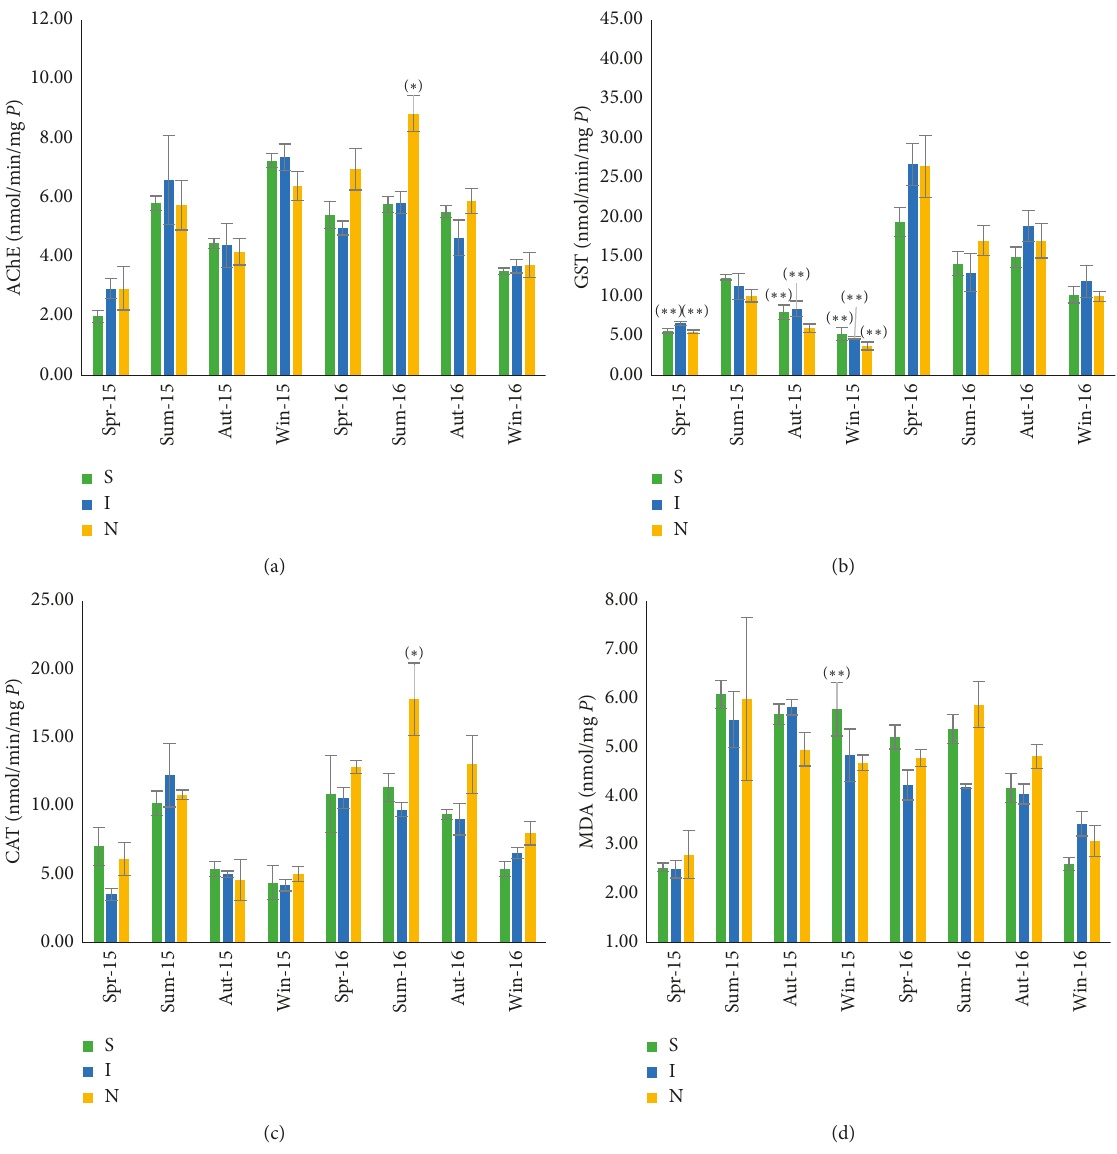
Figure 3: Seasonal variations of acetylcholinesterase (a), glutathione S-transferase, and (b), catalase activities (c) and malondialdehyde level (d) in Mytilus galloprovincialis collected in 3 sites (South (S), Instal (I), and North (N)) of the coastline Tifnit-Douira (Spr: Spring; Sum: Summer; Aut: Autumn; Win: Winter). Data were expressed as (mean ± SD) ( n � 6). Values indicate significant difference between sites ( ∗ ) and between stations ( ∗∗ ), p < 0 .